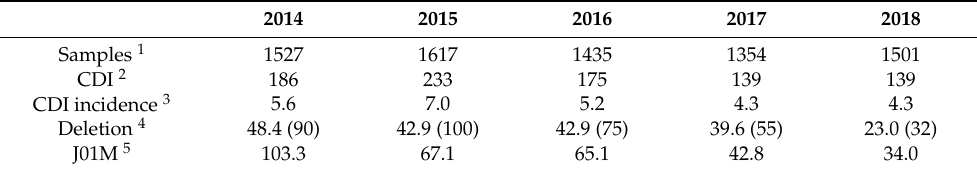
Table 1. Overview of CDI diagnostics and ATB consumption during years 2014 to